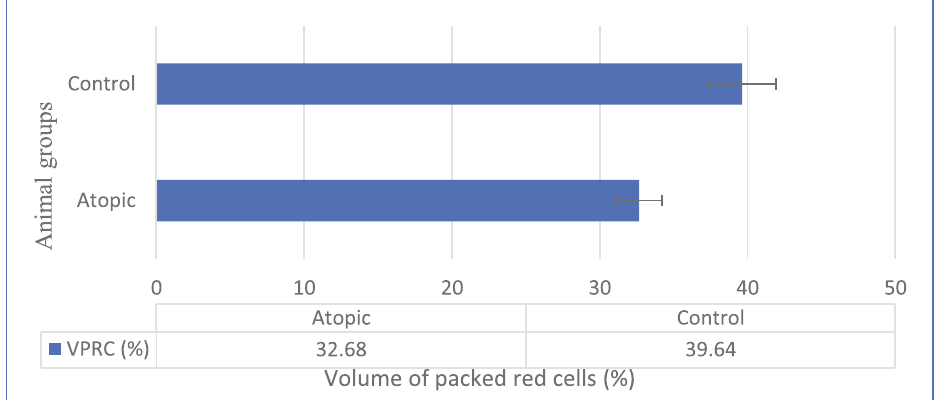
Fig. 2. Mean haemoglobin (g/dL) in atopic animals and healthy controls